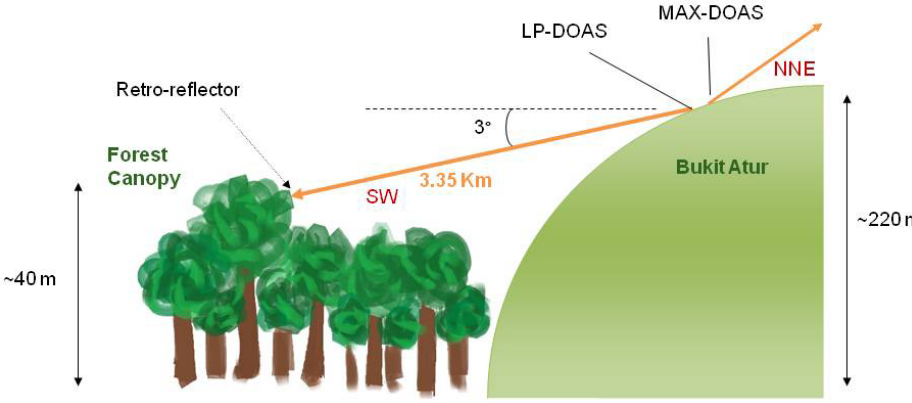
Fig. 2. Schematic diagram of the field site showing viewing directions for both DOAS instruments.